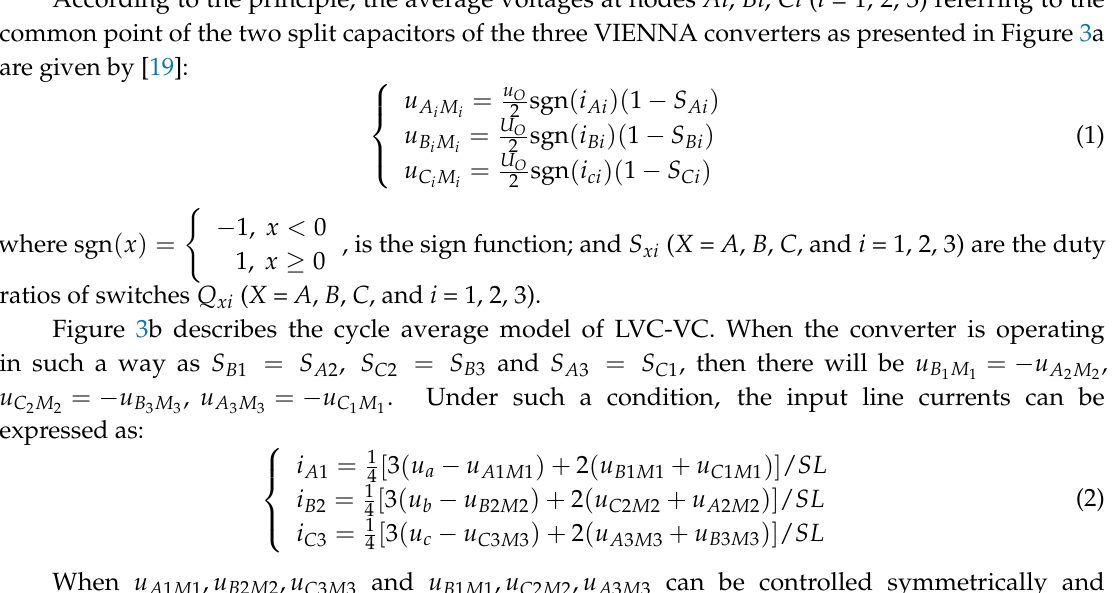
Figure 3. ( a ) triple line voltage cascaded VIENNA rectifier. ( b ) the switching cycle average model of the converter.